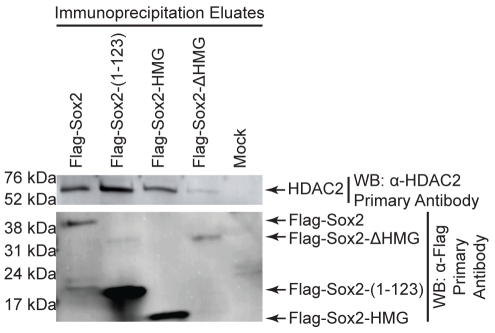
Co-immunoprecipitation of endogenous 293T cell HDAC2 by exogenous Flag-Sox2 constructs.The indicated constructs were transiently transfected into 293T cells, and nuclear proteins were prepared 1 day later. Flag-Sox2 proteins and associated proteins were co-immunoprecipitated from nuclear extracts using M2-beads. Immunoprecipitate eluates were used in western blot analyses, and were probed for either α-HDAC2 (top) or α-Flag (bottom). Protein for the control (mock) lane was from un-transfected 293T cells. This experiment was repeated, and similar results were observed.